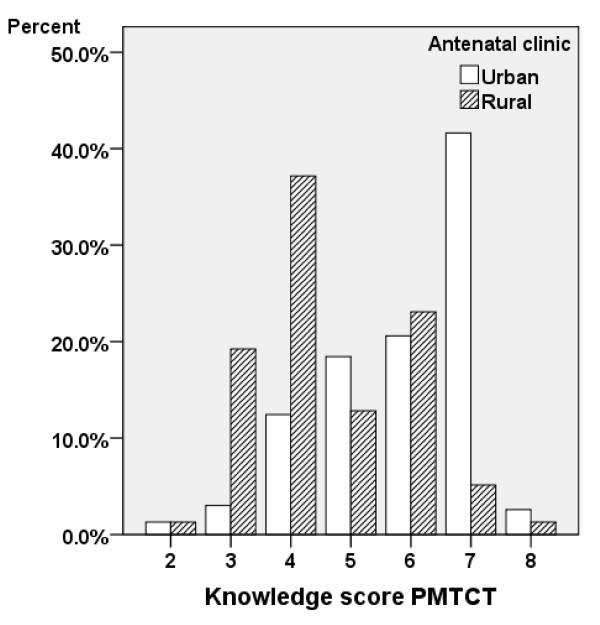
Knowledge score PMTCT by type of clinic attended.